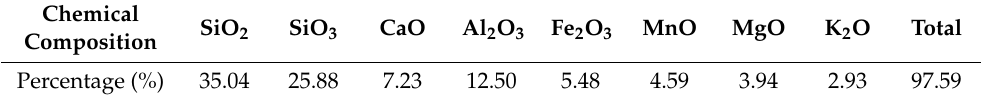
Table 3. Chemical composition of manganese slag.